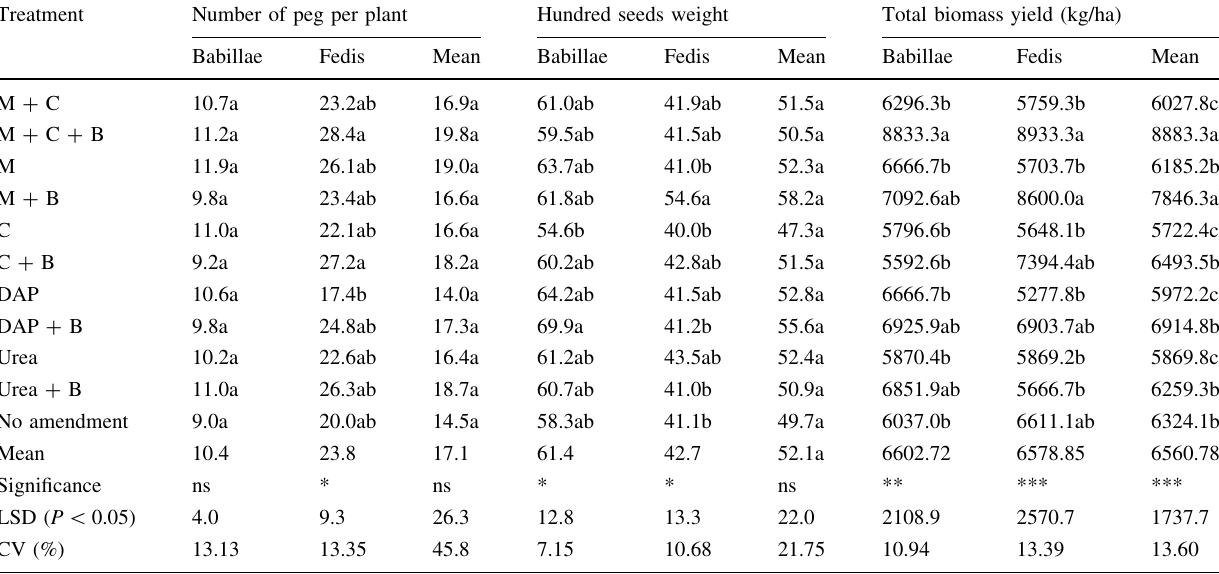
Table 3 Number of pegs per plant, hundred seed weight and total biomass yield of peanut as affected by combined application of organic and inorganic fertilizer application at Babillae and Fedis sites, eastern Ethiopia